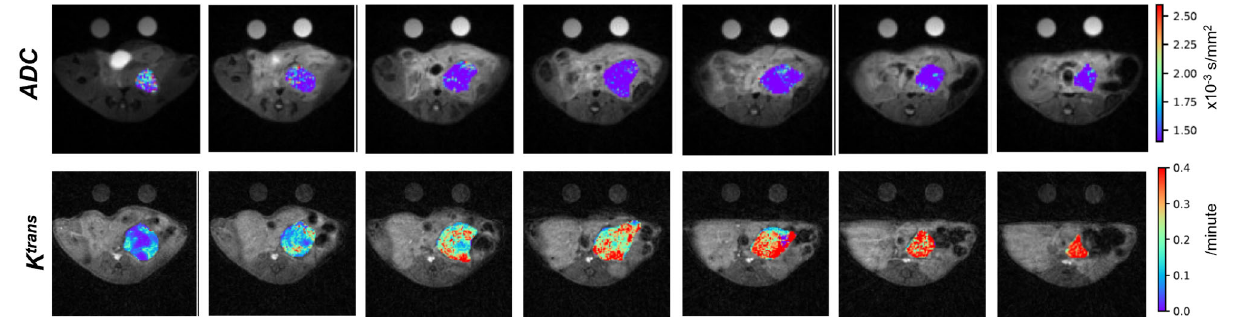
Figure 6. ADC maps ( upper row) and Ktrans maps ( bottom row) of PDA tumor from a KPC mouse. Parametric maps are overlaid on T2W images and displayed in pseudo color using the color bars on the right. Suitable phantoms for DW- and DCE-MRI are scanned with the mouse for quality control.